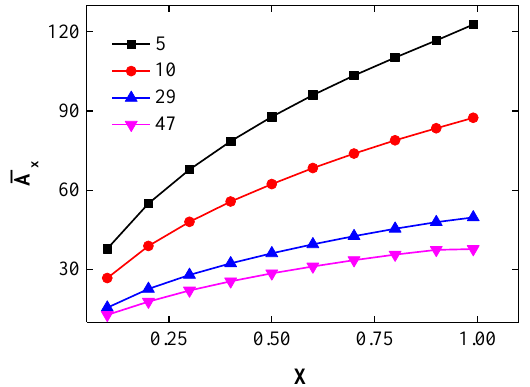
A vs. the area fraction of the Type II grains. Figure 10. Plot of A x vs. the area fraction of the Type II grains. x